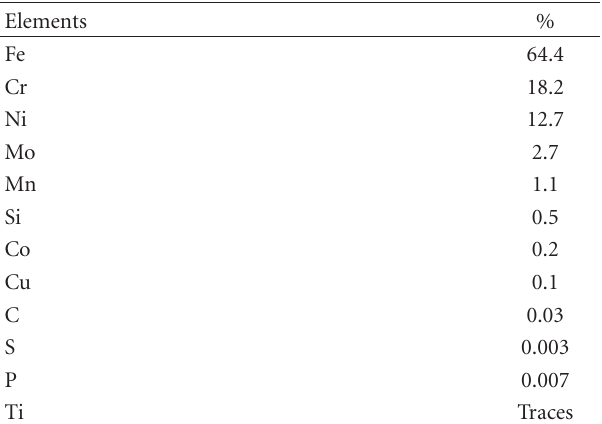
Table 1: Ferrous scrap